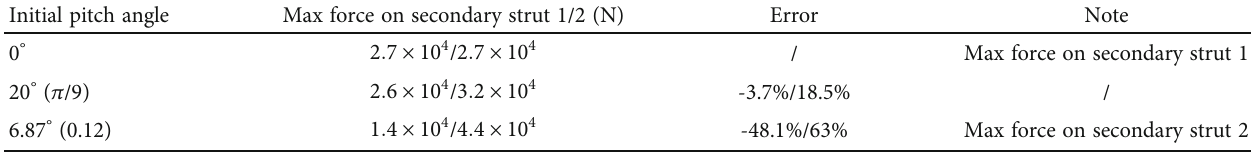
Table 11: Impact of typical working conditions of initial pitch angle on the maximum force of secondary strut.